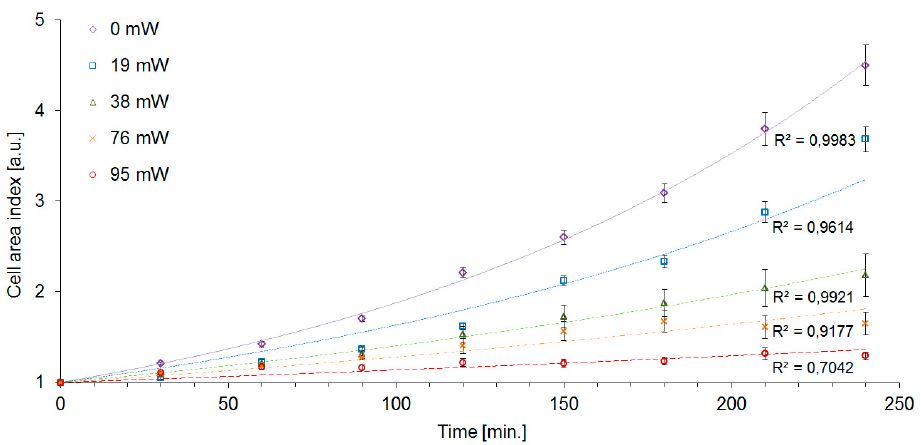
Figure 6. Cell area index (CAI) of S. cerevisiae cells trapped for 15 min in optical tweezers at the wavelength of 1064 nm using the trapping laser power P c in the range from 19 mW to 95 mW. The 0 mW curve corresponds to the control unexposed cells. The data were fitted with exponential trend lines. Error bars represent the standard error of the mean (SEM).